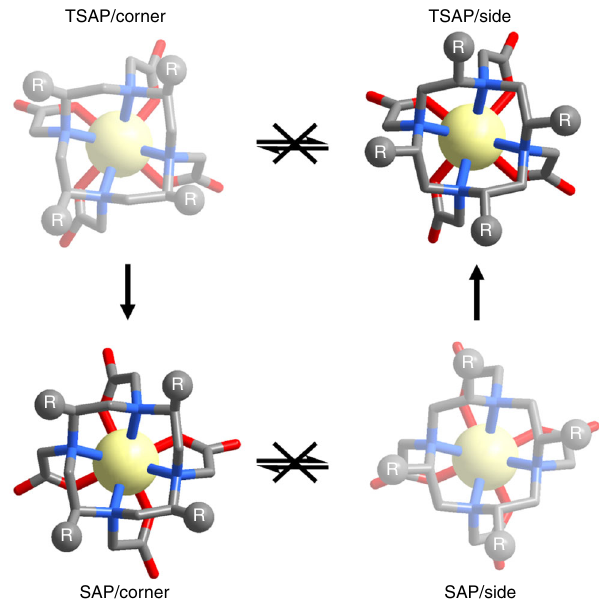
Fig. 6 Restricted isomerism of [GdL3] − . Four stereoisomers are possible for [LnDOTA] − , but two of these structures are inaccessible with our system, they are represented by the washed out structures. SAP/corner and TSAP/ side structures derived from the partial solved crystallographic data of [GdL3] − ; R represents the chiral substituent. Atom labels: C (grey), N (blue) and O (red); H atoms omitted for